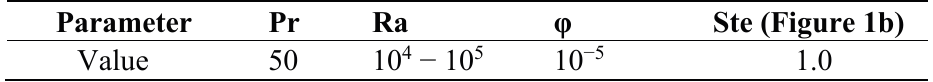
Table 4. The simulation parameters of